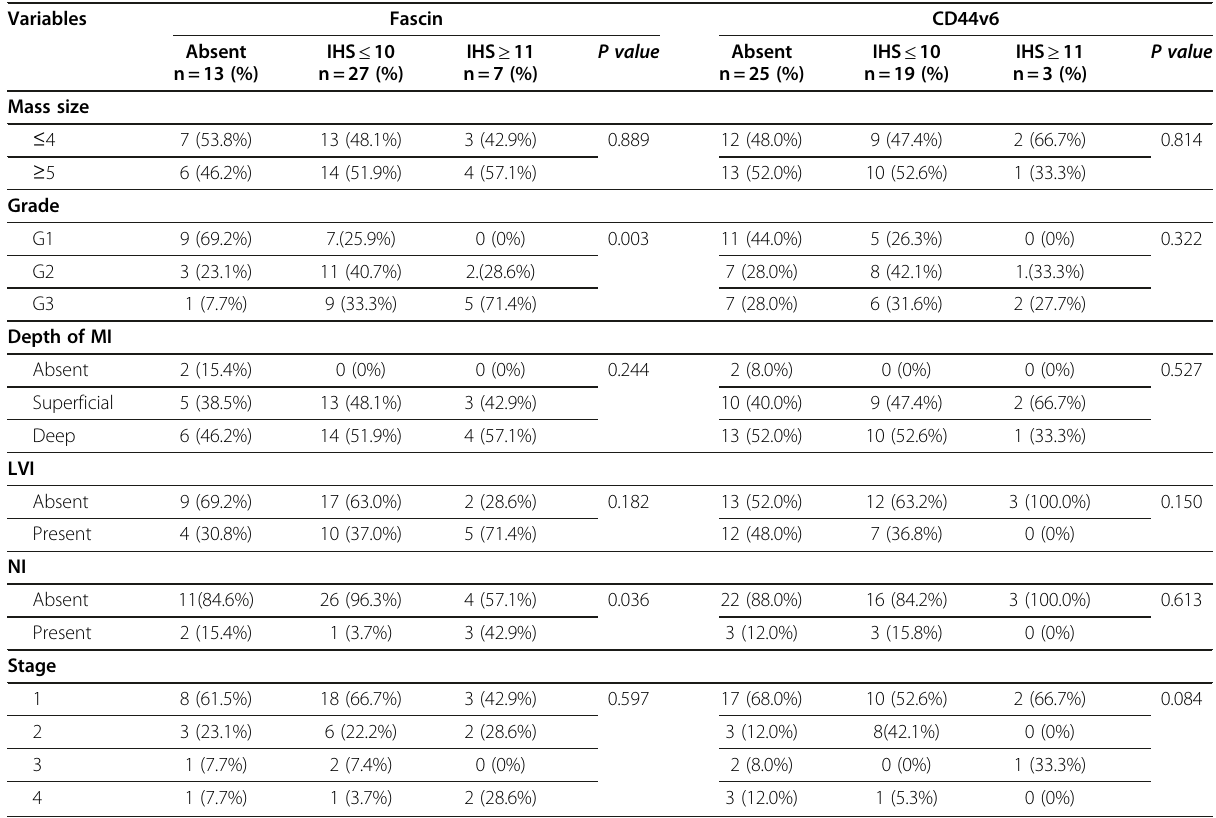
Table 2 Correlation of clinicopathological parameters with fascin and CD44v6 expressions in 47 endometrioid